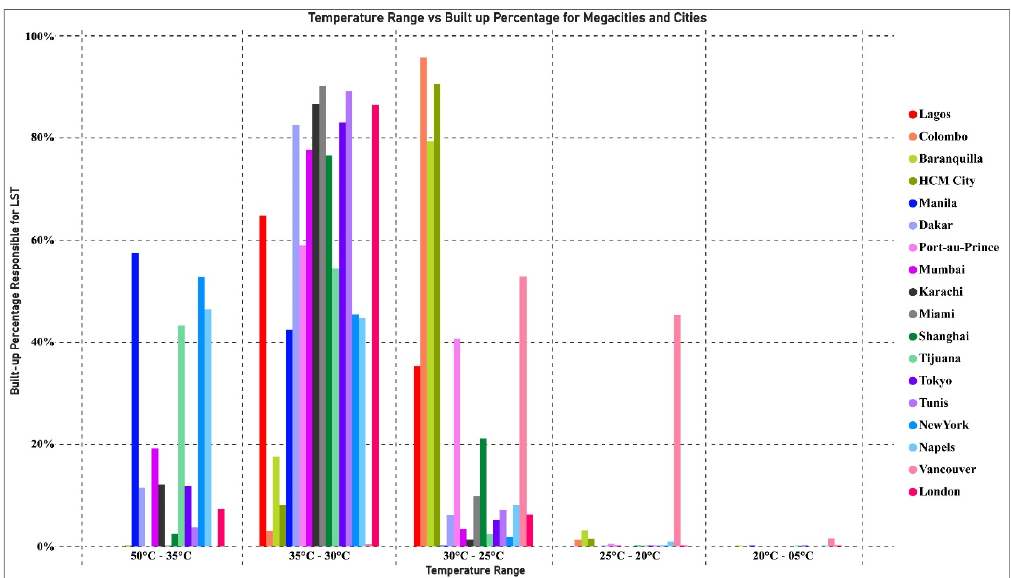
Figure 6. Temperature range and built-up percentage for each city and megacity.